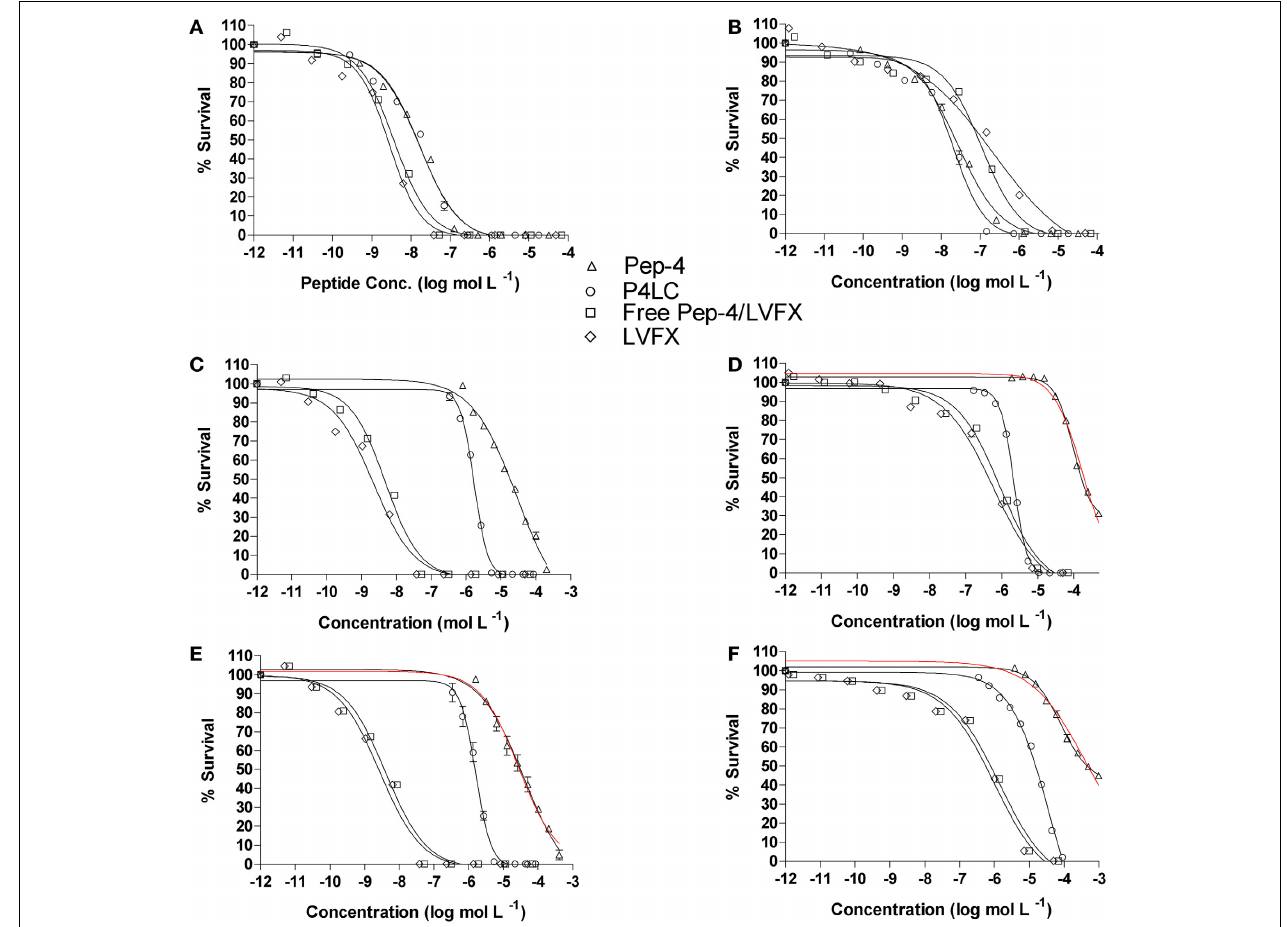
FIGURE 4 | Antibacterial effectiveness of P4LC, Pep-4, Pep-4/LVFX and LVFX against E. coli (A,C,E) and B. cereus (B,D,F). The top row (A,B) were generated for assays performed in low total ionic strength (26mM), the middle row (C,D) for intermediate total ionic strength (111mM), and the bottom row (E,F) for high total ionic strength (167mM) conditions. Data were fit to equation 3, a standard variable